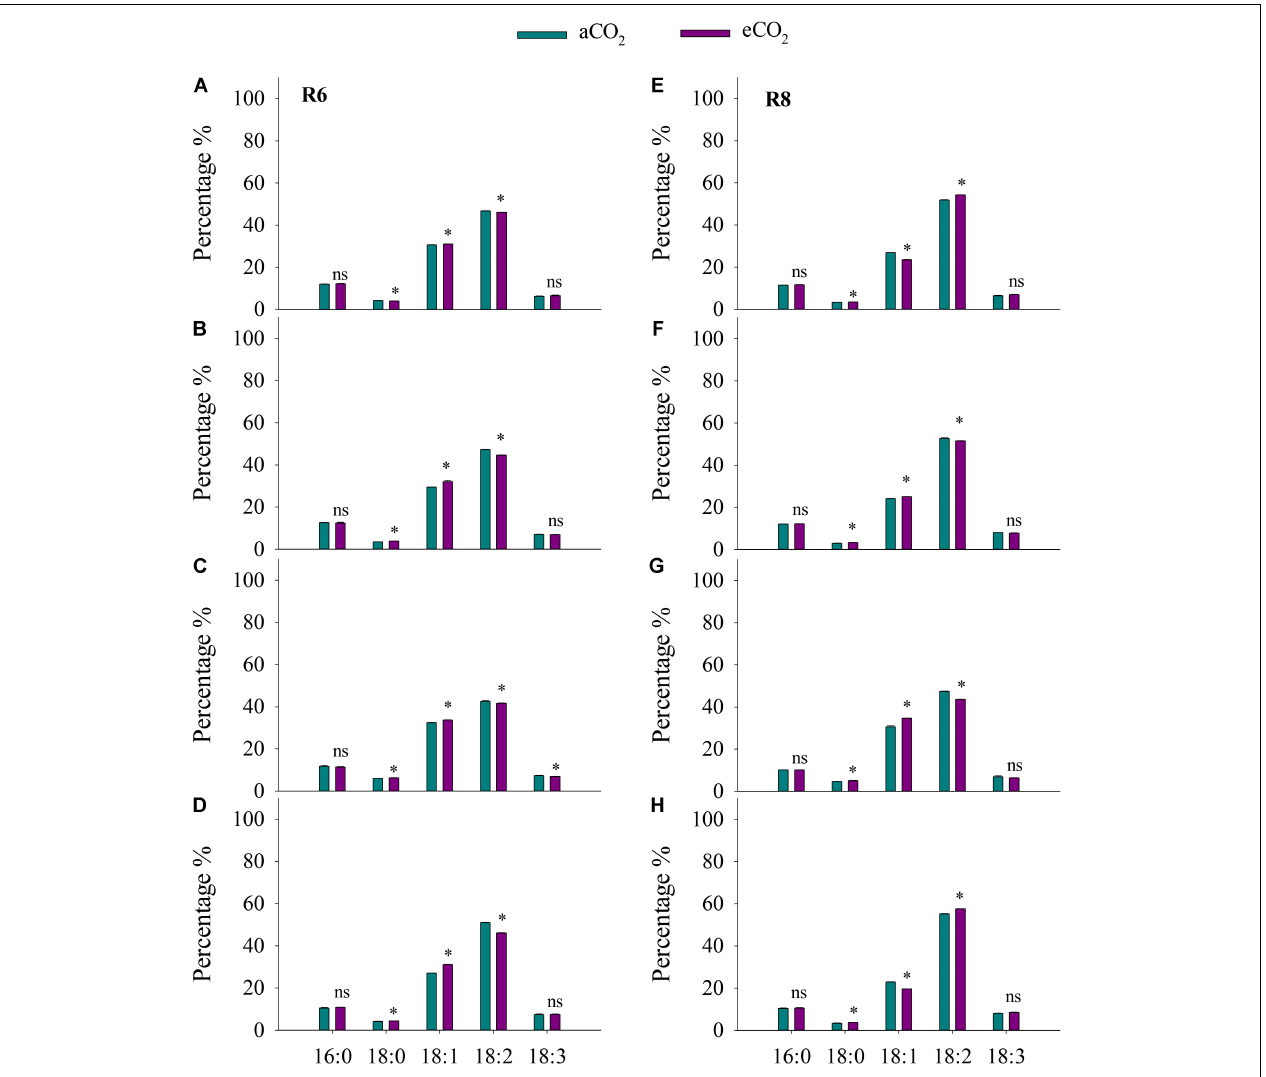
FIGURE 4 | Influence of elevated CO 2 on the percentage of palmitic (16:0), stearic acid (18:0), oleic acid (18:1), linoleic acid (18:2), and linoleic (18:3) acid of ZK-1 (A) , ZK-2 (B) , ZK-3 (C) , and HD (D) at the fresh edible stage (R6) and ZK-1 (E) , ZK-2 (F) , ZK-3 (G) , and HD (H) at the mature stage (R8); error bars represent the standard error ( n = 3). Significant differences between CO 2 treatments for each cultivar are noted with an asterisk at P <